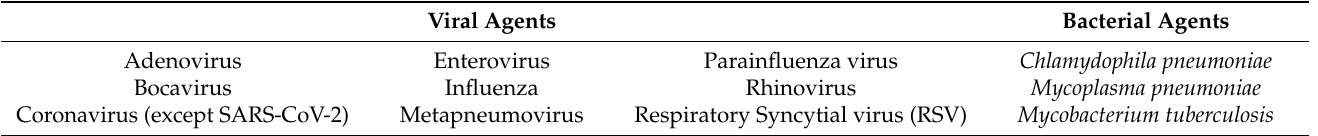
Table 1. Viral and bacterial agents causing symptoms similar to COVID-19. Viral Agents Bacterial Agents Adenovirus Enterovirus Parainfluenza virus Chlamydophila pneumoniae Bocavirus Influenza Rhinovirus Mycoplasma pneumoniae Coronavirus (except SARS-CoV-2) Metapneumovirus Respiratory Syncytial virus (RSV) Mycobacterium tuberculosis Adapted from Borghetti et al. (2020)